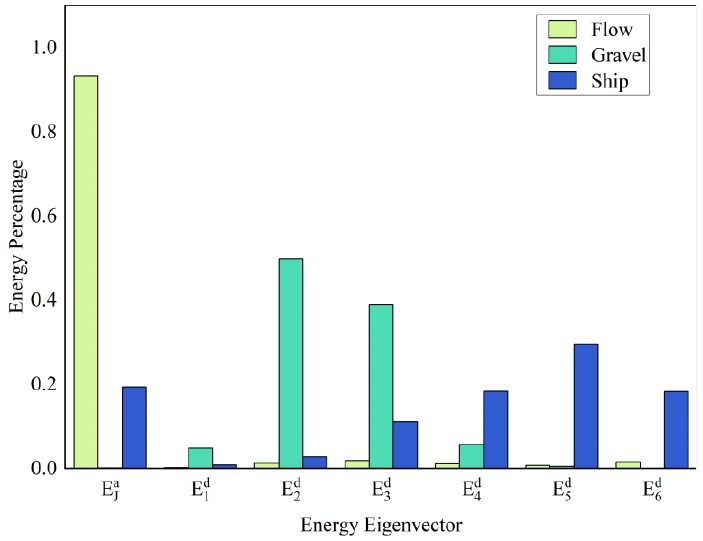
Figure 11. Energy eigenvector distribution characteristics of three kinds of acoustic signals.